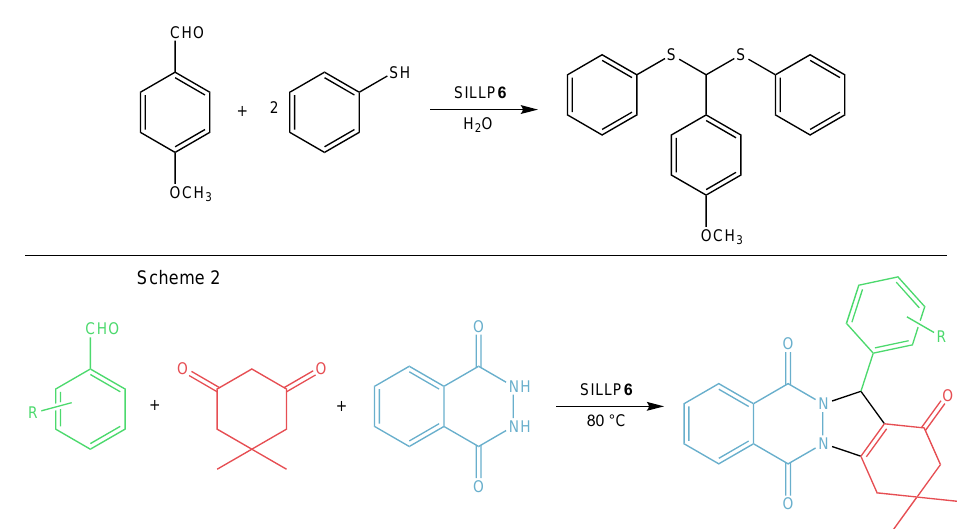
Figure 13. Brønsted-type SILLP based on silica material in the synthesis of thioacetalization of (Scheme 1)), 2H-indazolo[1,2-b]phthalazine-triones (Scheme 2).